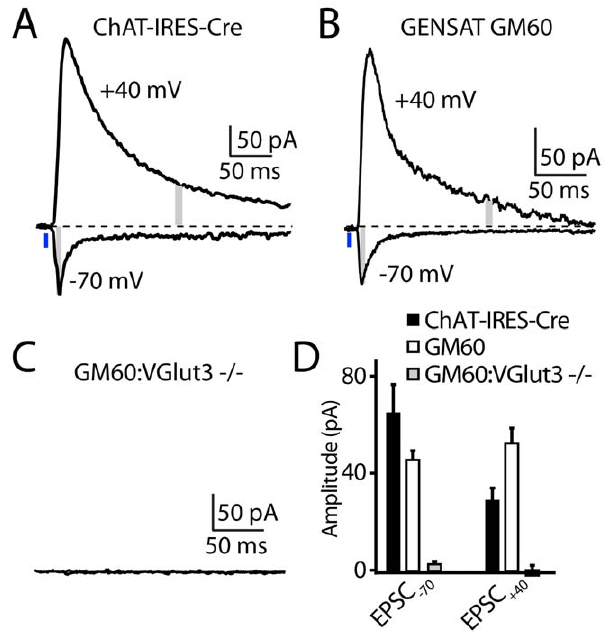
Figure 3. CIN-mediated glutamatergic currents in MSNs require VGluT3 expression. (A) Example light-evoked EPSCs at 32–34 u C in an MSN held at 2 70 or + 40 mV in an acute striatal slice of a DFI-ChR2- mCherry AAV injected ChAT-IRES-Cre mouse. (B) As in Panel A, showing recordings at 32–34 u C obtained from an MSN in an acute slice of a DFI- ChR2-mCherry AAV injected GM60 mouse that expresses Cre under control of a BAC spanning the ChAT genomic locus. (C) As in Panel B, showing failures to evoke EPSCs in an MSN of a DFI-ChR2-mCherry AAV injected GM60; VGluT3 2 / 2 mouse. (D) Average light-evoked EPSC amplitudes measured in MSNs at holding potentials of 2 70 and + 40 mV in acute slices prepared from mice of the indicated genotypes.